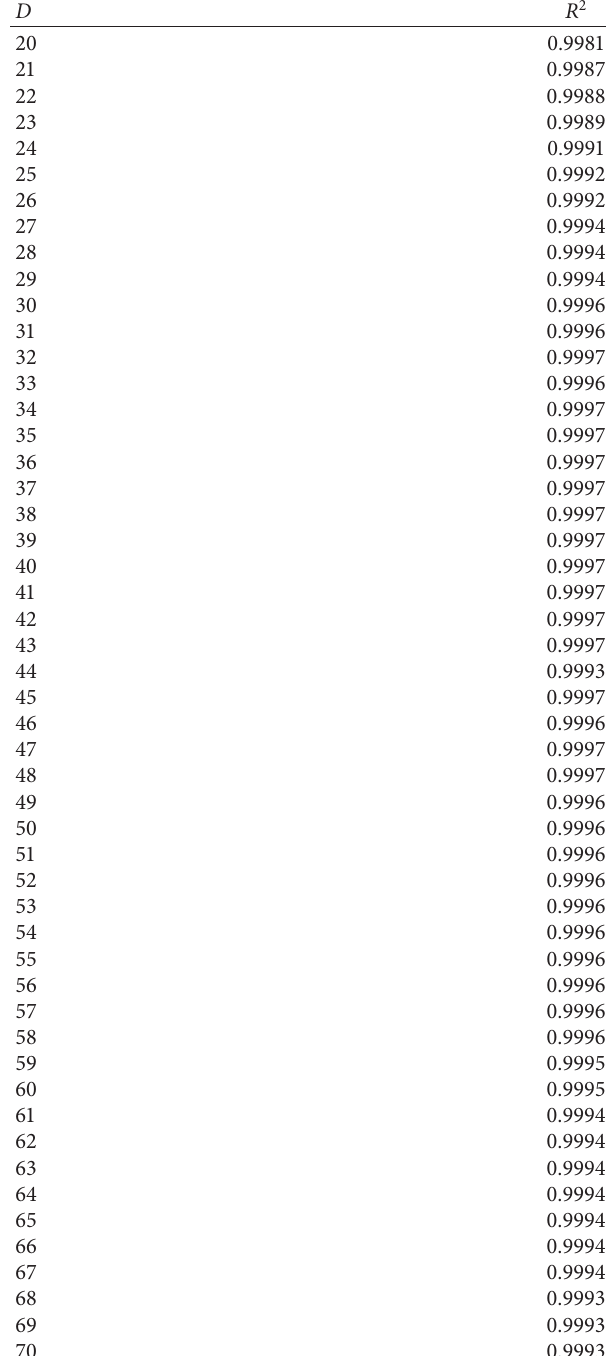
Table 2: Adjustment of data in Raimondi’s tables to the function